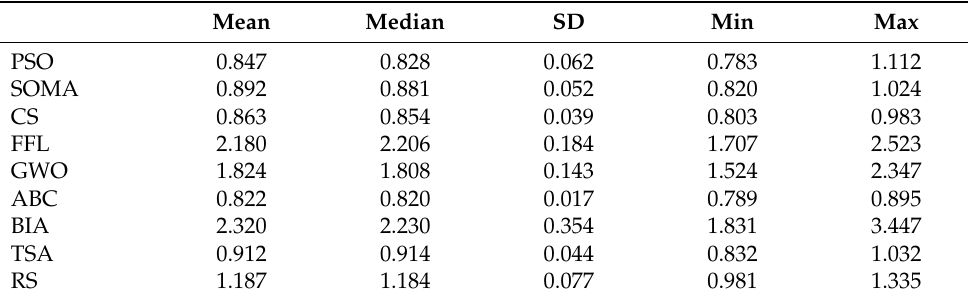
Table 4. Comparison of algorithms for Function f 4 .